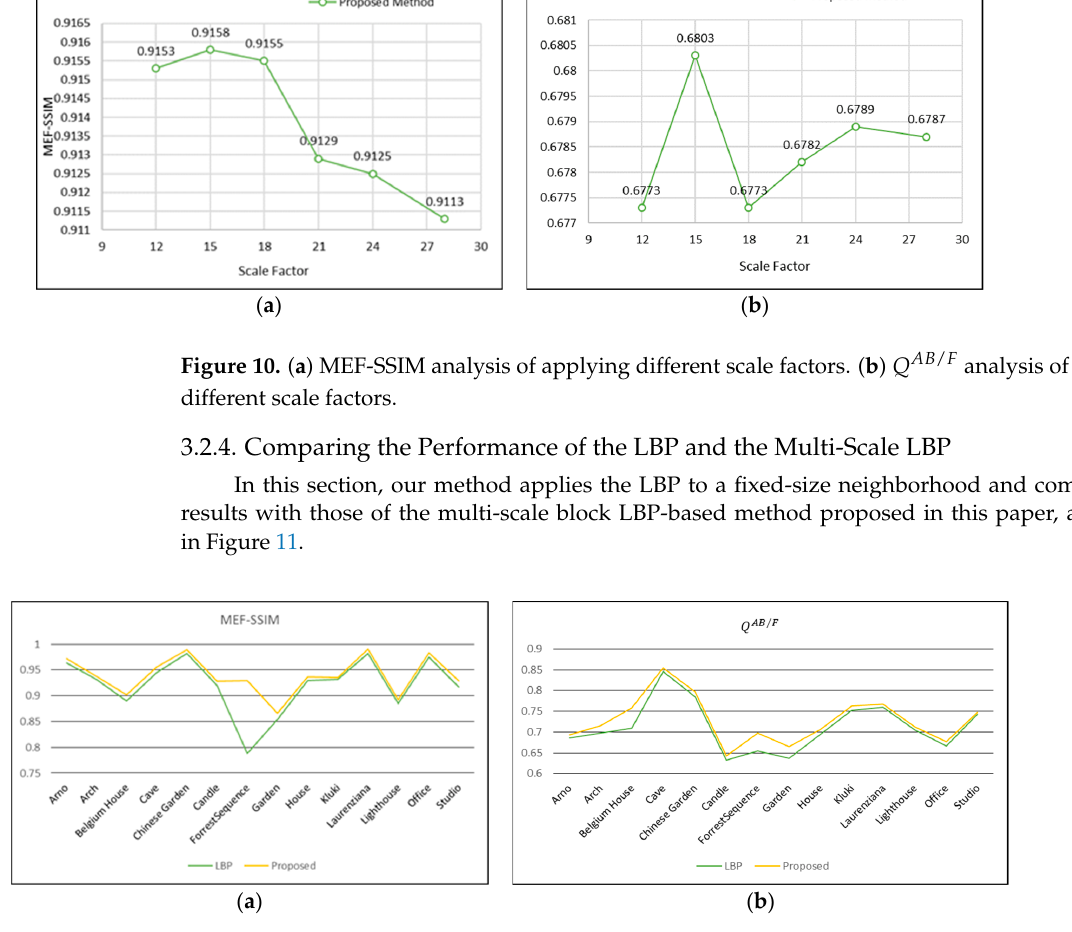
Figure 11. ( a ) MEF-SSIM analysis of applying neighborhoods of fixed-size LBP and multi-scale block LBP. ( b ) Q AB/F analysis of applying neighborhoods of fixed-size LBP and multi-scale block LBP.